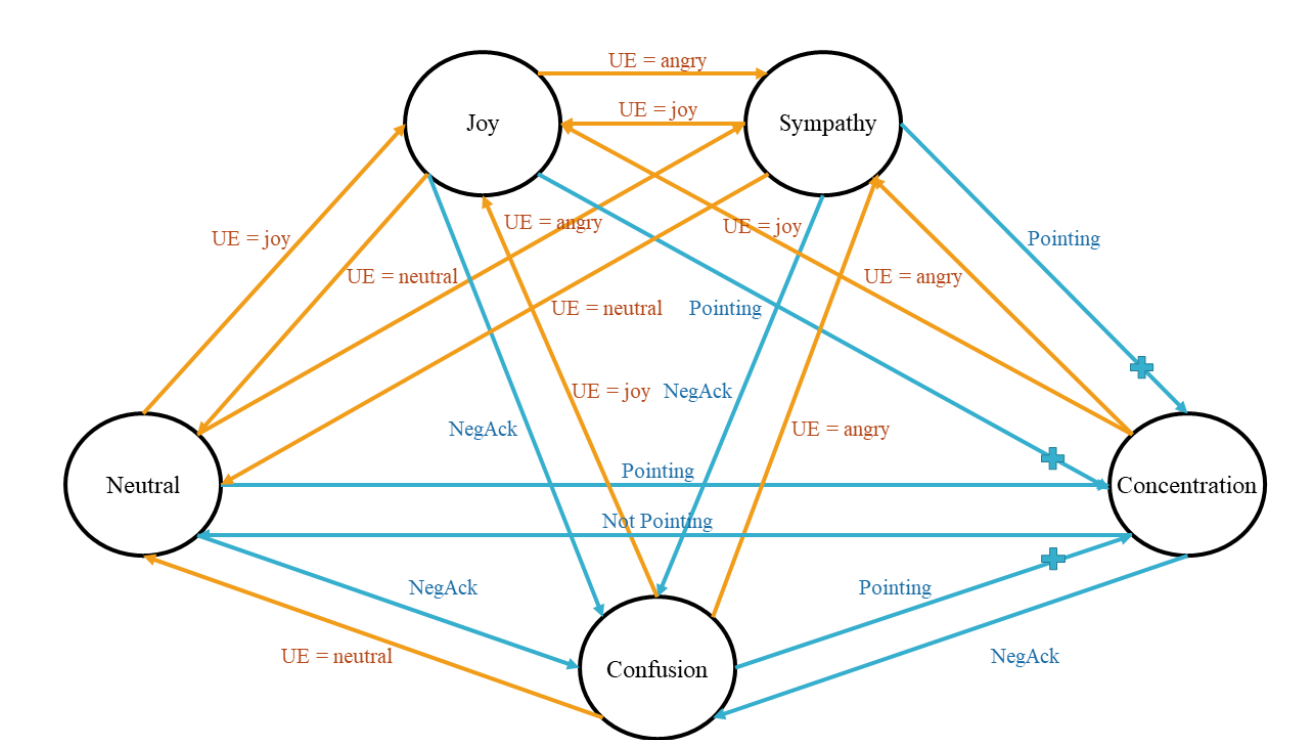
Figure 11. A diagram of the finite state machine of Diana’s affective states. The concrete conditions of transitions